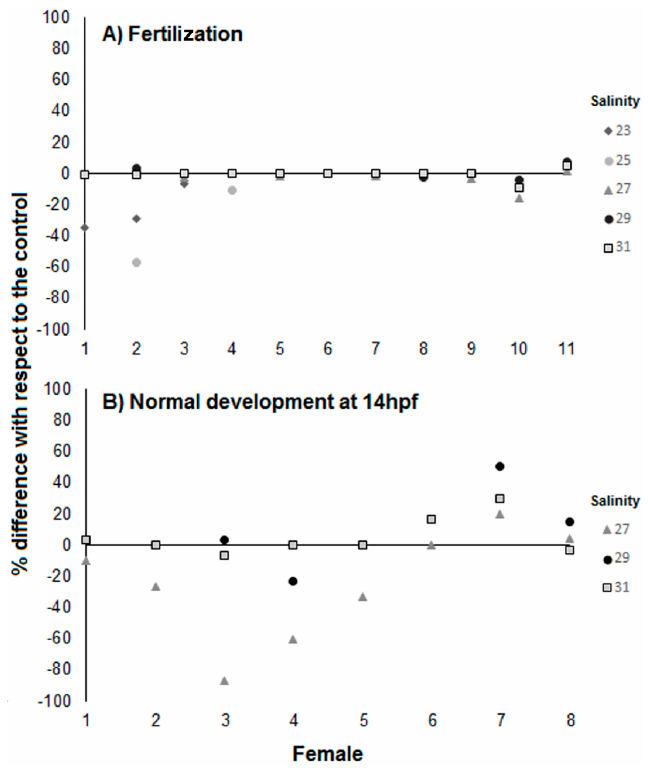
Figure 4. The difference in fertilization and early developmental success with respect to the control treatment (salinity of 34 ppt) grouped by female across experimental salinity treatments. Mean success per female is displayed for the different salinity levels across fertilization ( A ) and normal development 14 h post fertilization ( B ). Symbols above the line display higher success than the control, while success was lower than the control for those symbols below the